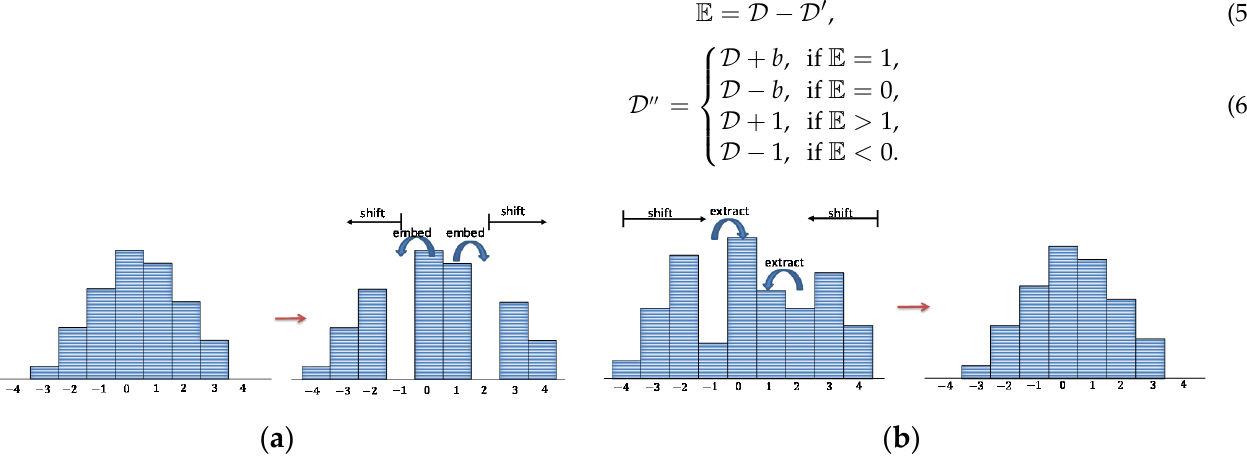
Figure 1. Illustration of data embedding and extraction based on histogram shifting; ( a ) Data embedding process ; ( b ) Data extraction process .